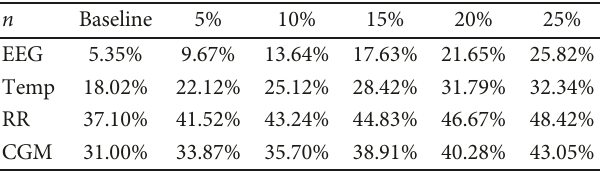
Table 4: Final percentage of equal values in each database, speci fi cally for n = 8 . The fi rst column, baseline, corresponds to the level found right after signal acquisition, and the rest of the columns correspond to the resulting percentage after merging randomly synthetic equal values and those found initially in the